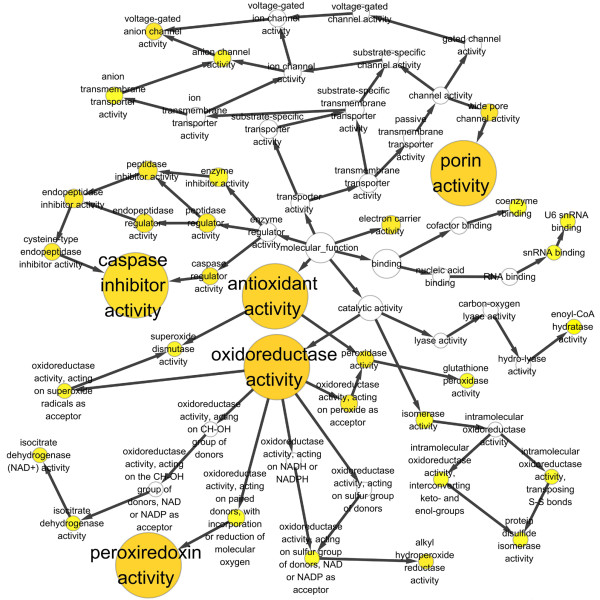
Enriched molecular functions of differentially expressed mitochondrial proteins between metastatic 5-8F and nonmetastatic 6-10B cells. A circle represents a molecular function. An arrow represents the relationship between two molecular functions. The color from white to deep yellow represents different p-values.